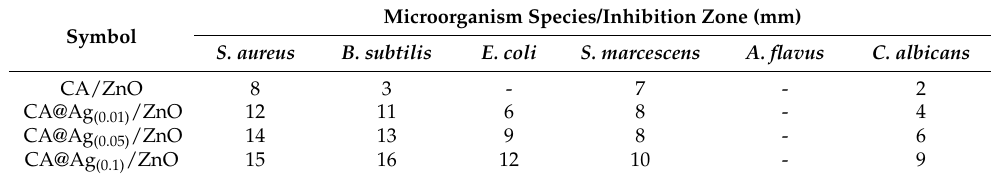
Table 1. Antimicrobial activities of CA/ZnO and CA@Ag (0.01, 0.05, 0.1) /ZnO hybrid materials.